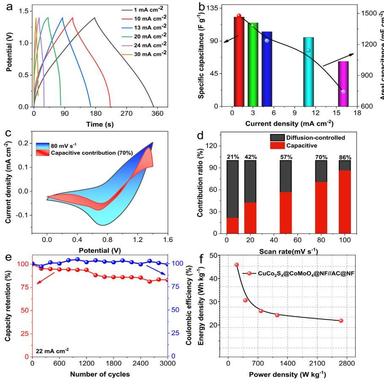
(a) GCD curves the fabricated ASC device. (b) Specific capacitance plotted as a function of the current density. (c) Capacitance contribution diagram constructed at a scan rate of 80 mV s1 . (d) Capacitance contribution ratios of the diffusion-controlled and capacitive charges obtained at different scan rates. (e) Cycling stability and coulombic efficiency of the ASC device. (f) Energy density plotted as a function of the power density.